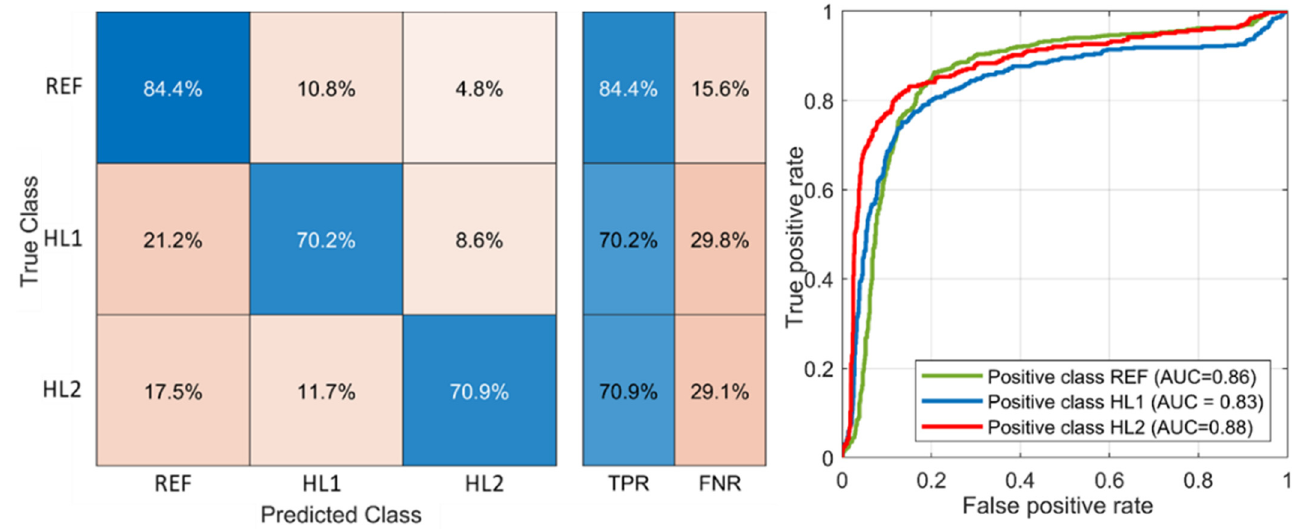
Figure 20. The misclassification matrix ( left ) and ROC-plot ( right ) for CUBIC SVM classifier.